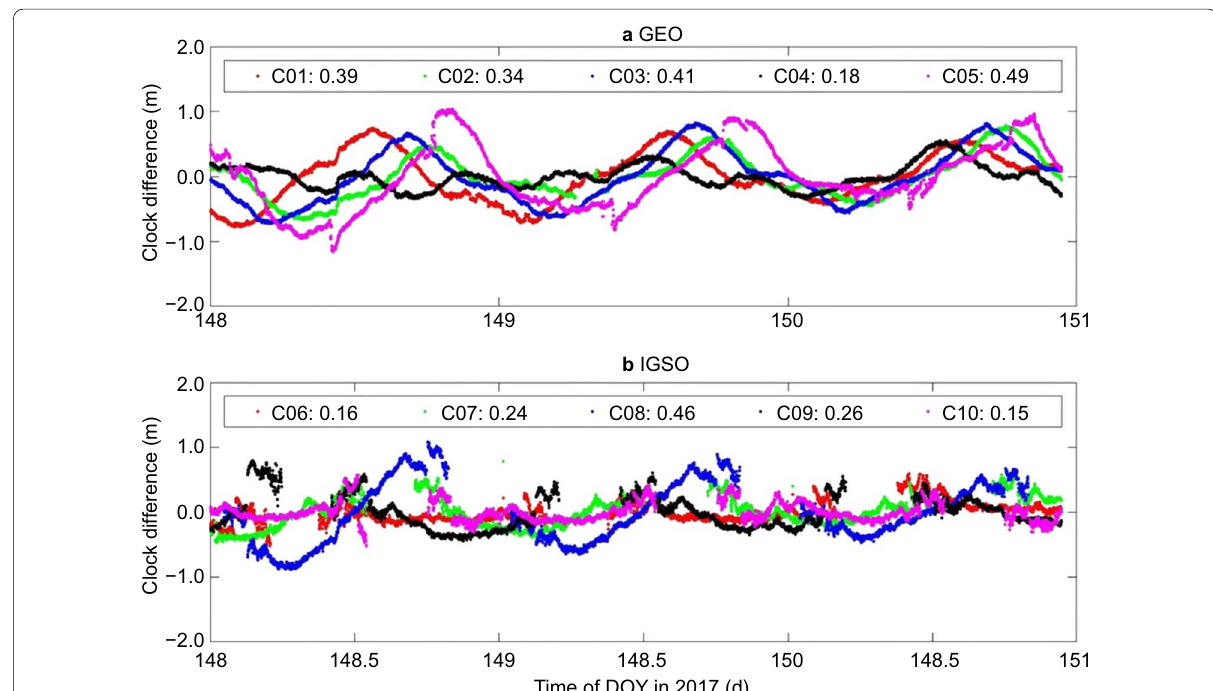
Fig. 2 Satellite clocks differences between ODTS and TWSTFT techniques used for the period of Doy of Year (Doy) 148–150 in 2017, where average biases are subtracted for each satellite and only the periodic variations are shown. The value in the legend box shows the Standard Deviation (STD) of the clock differences for the corresponding